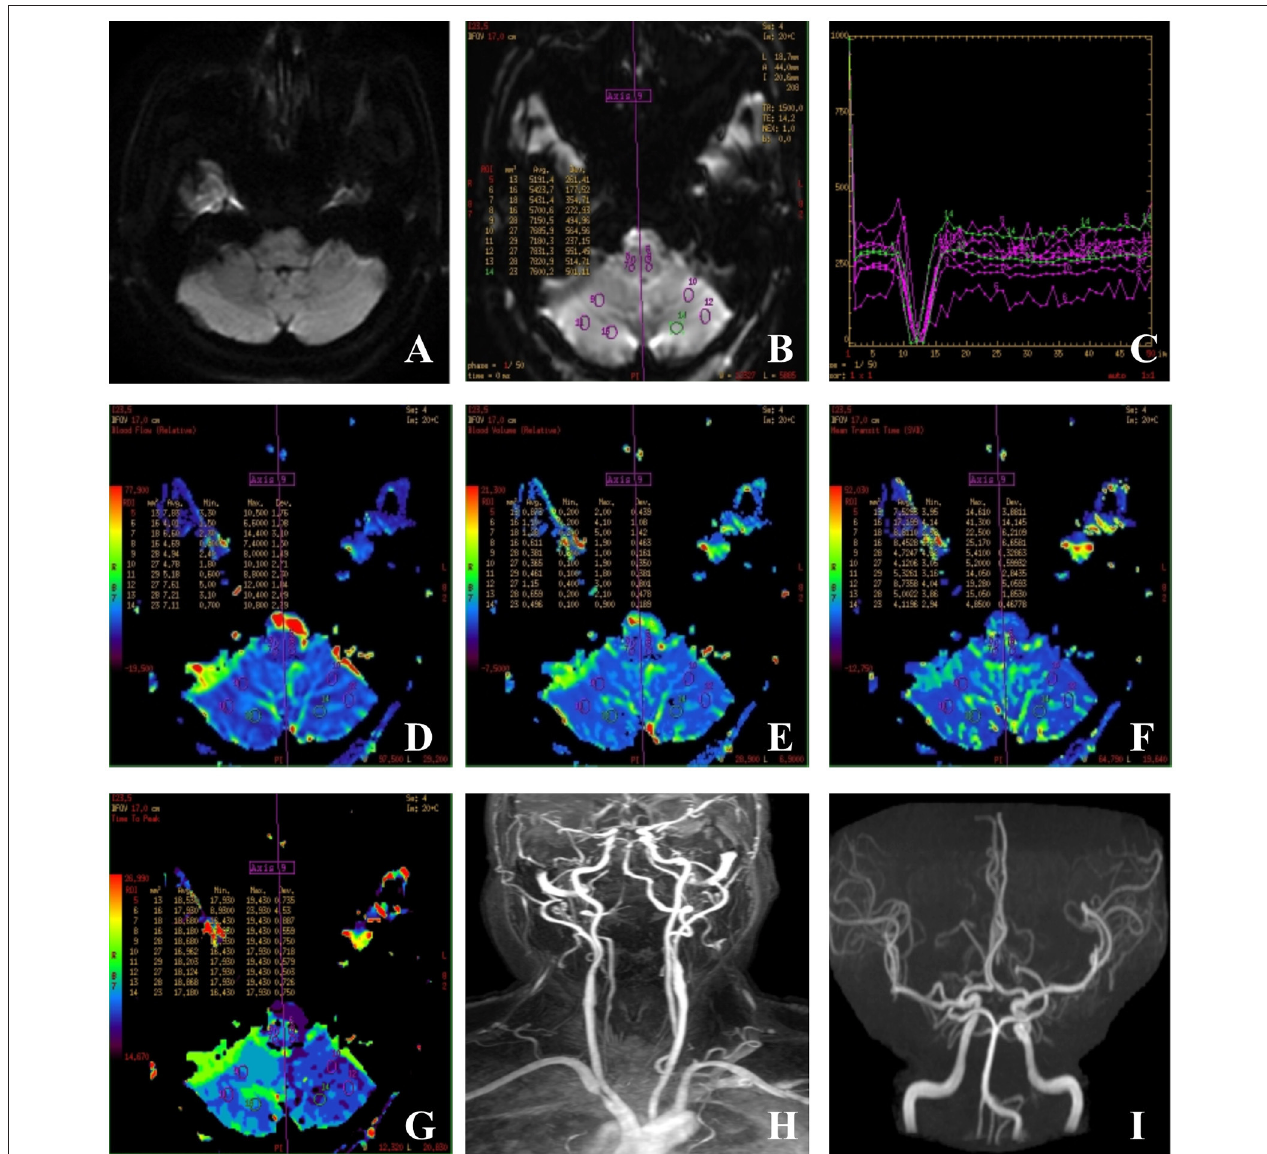
FIGURE 2 | Images of a case of isolated vertigo suspected to be caused by hypodynamics of brain. (A) Sixty-one-year-old man had isolated vertigo on 4 April 2016 and performed with MRI, MRA, CEMRA, and PWI. (A) DWI-MRI was normal and showed no acute infarctions; (B) outlines of ROIs of bilateral cerebellum and medulla; (C) time-signal intensity curve; (D,E) cerebral blood flow (CBF) and cerebral blood volume: a similar color differences were not observed in the rCBF and rCBV panels. (F) Mean transit time (MTT): values of the right cerebellum varied from the left ones and are not obvious; (G) time to peak (TTP): TTP values obtained for the right cerebellum are longer than those obtained for the left cerebellum; (H,I) CEMRA and MRA showed the tortuous, dominant left vertebral artery, and severe stenosis at the beginning point.